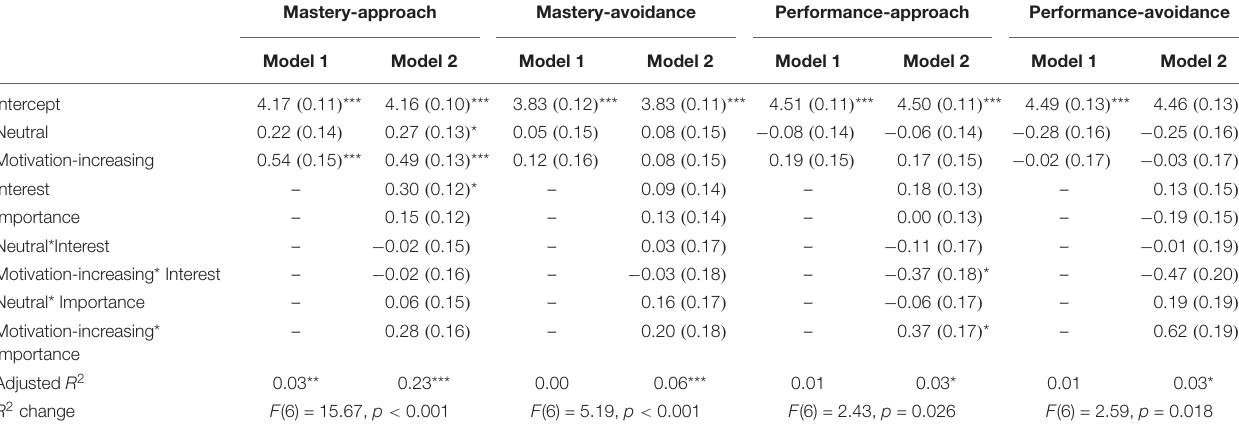
TABLE 3 | Summary of regression coefficients, predicting achievement goals from implicit belief profiles, course interest, and course importance.